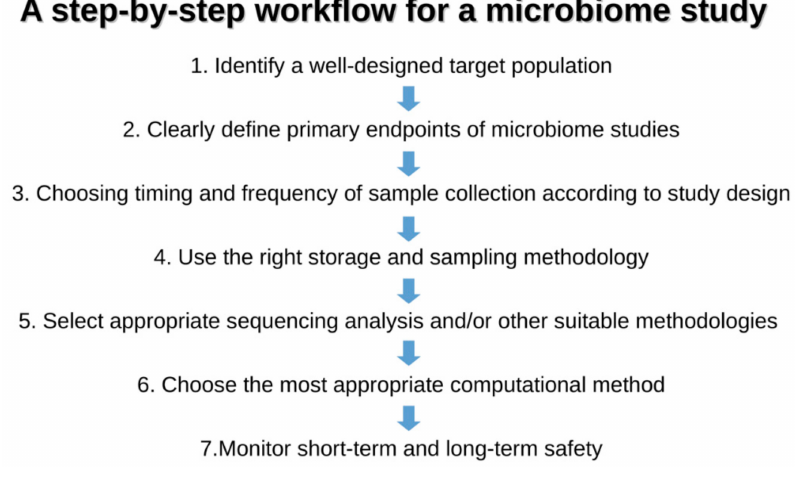
Figure 1. The figure represents the seven golden steps that the pediatrician should follow before the enrollment of individuals / patients in the microbiota